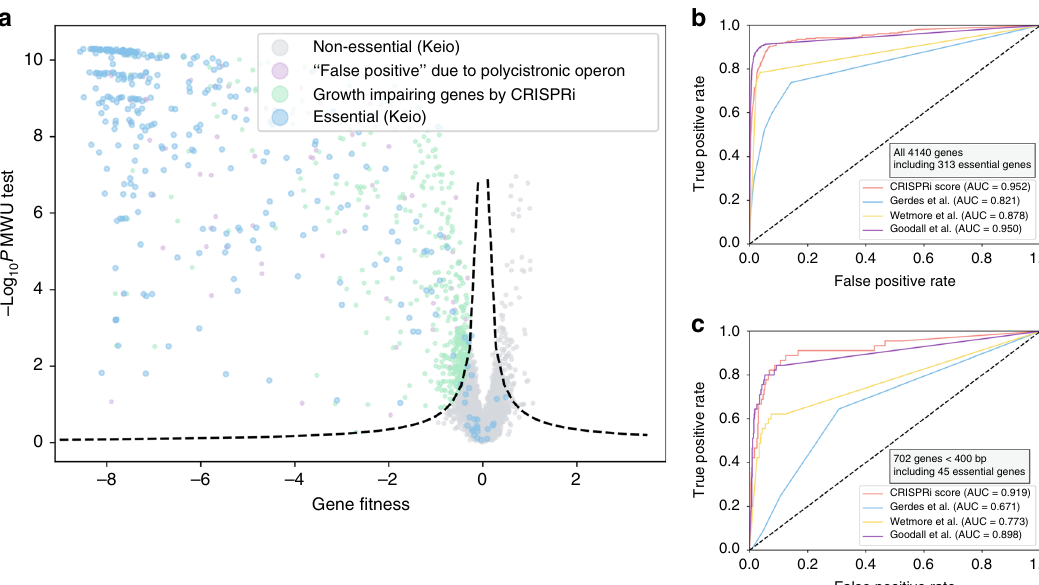
Fig. 3 Predicting E. coli essential genes from CRISPRi screening. a Volcano plot of gene fi tness and − Log 10 P value of two-tailed MWU test. Dashed lines represent a threshold (FDR = 0.05) for calling hits based on the screening score (see Methods). Four groups of genes are shown: blue, 313 essential genes from the Keio collection (Supplementary Data 11); gray, non-essential genes from the Keio collection and assigned as true negatives by CRISPRi screening; purple, false-positive “ required ” genes assigned by CRISPRi screening, potentially because of downstream Keio collection essential genes in operons transcribed as polycistronic mRNA; green, other genes found by CRISPRi screening to signi fi cantly inhibit cell growth. b and c ROC curves indicate the performances of different methods in identifying essential genes when considering all 4140 protein-coding genes ( b ) and 702 protein-coding genes with smaller coding regions (<400 bp) ( c ). True-positive rates and false-positive rates were calculated using the gold-standard set of essential and nonessential genes from the Keio collection 1 . Shown are ROC curves for CRISPRi screening (55,671 sgRNAs) (red, CRISPRi score), a benchmark Tn-seq experiment (152,018 unique transposon insertions) (yellow, Wetmore et al. 25 ), a recently reported Tn-seq dataset with unprecedented-density transposon library size (901,383 members) (purple, Goodall et al. 29 ) and a widely used transposon insertion — based genetic footprinting dataset (blue, Gerdes et al. 28 ). The dashed line represents a random guess of the essential